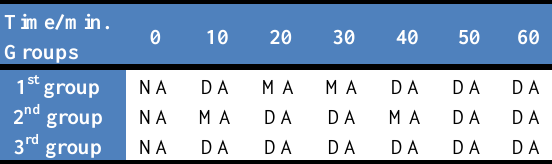
Table, 3: Shows Evaluation of analgesia in the three groups.